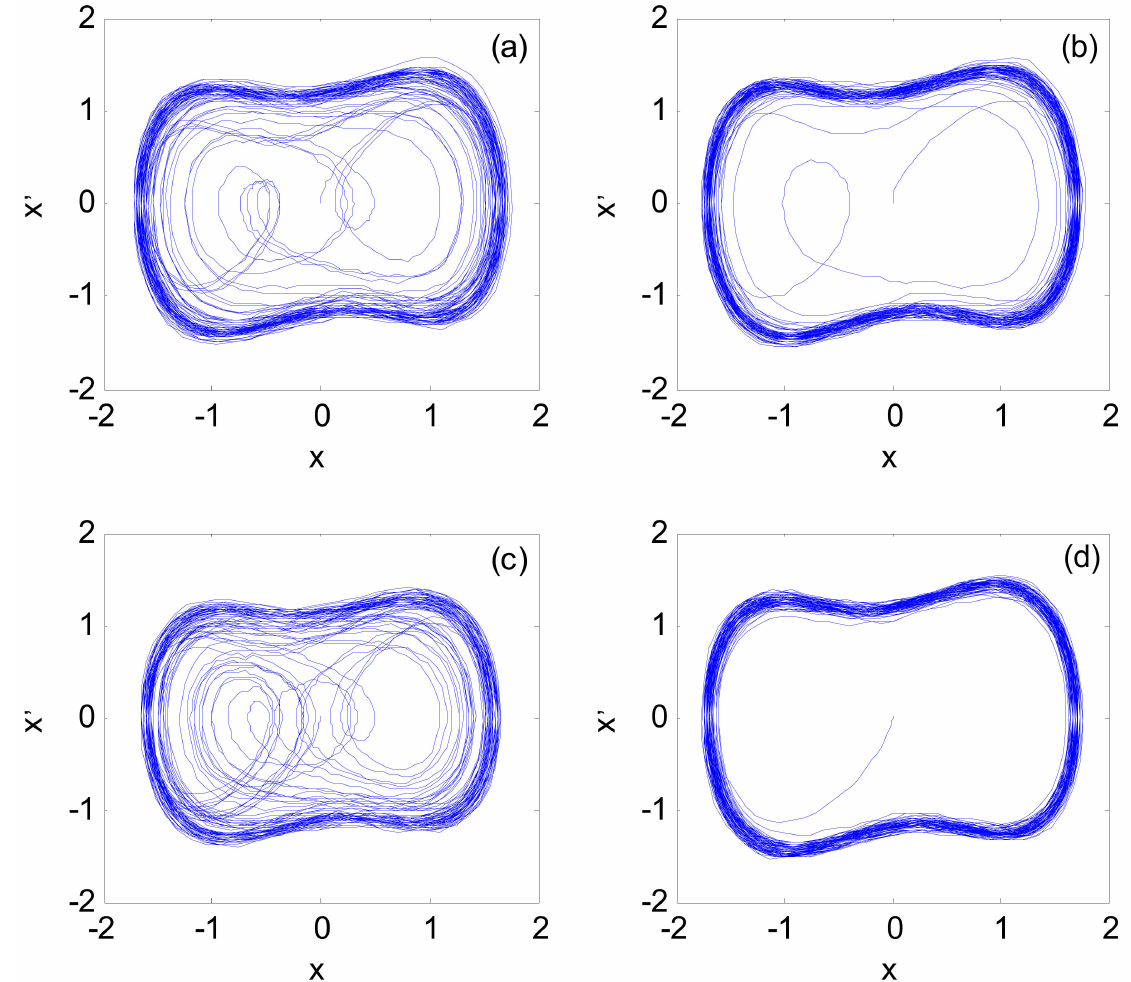
Figure 10. Phase space of a chaotic system: ( a ) while α = 0 and A a 1 = 0.8367; ( b ) while α = 0 and A a 1 = 0.8368; ( c ) while α = π and A a 2 = 0.8167; ( d ) while α = π and A a 2 =